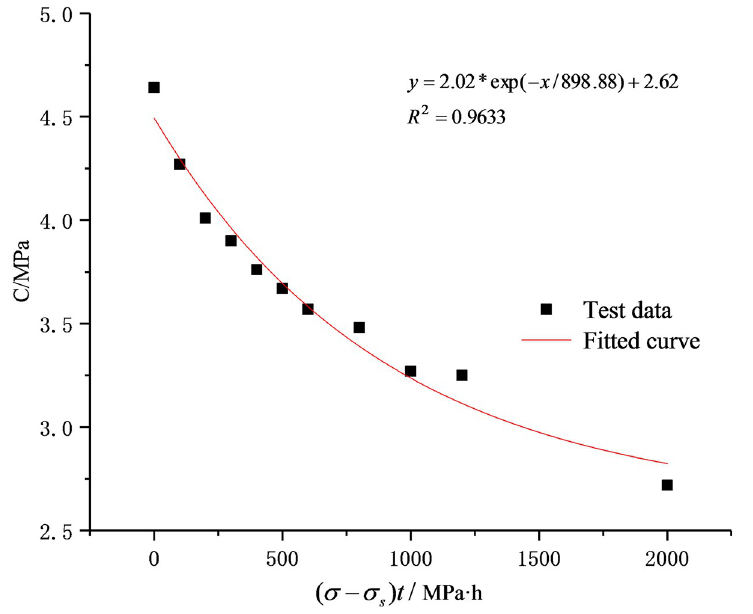
Fig 2. Relationship between cohesion and ( σ - σ s ) t